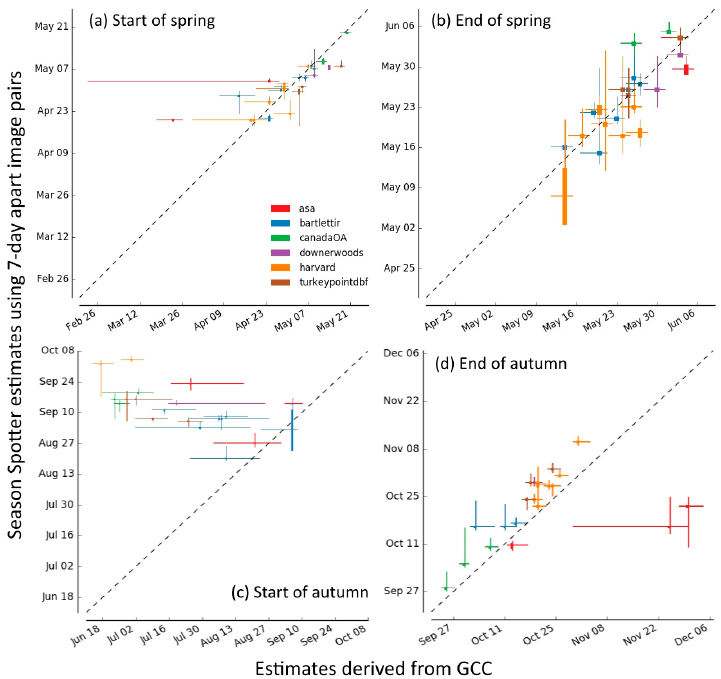
Figure 11. Comparison between phenophase transition dates derived from G CC values and those calculated from Season Spotter for ( a ) start of spring; ( b ) end of spring; ( c ) start of autumn; ( d ) end of autumn. G CC -derived estimates are calculated using 10% and 90% signal amplitude.